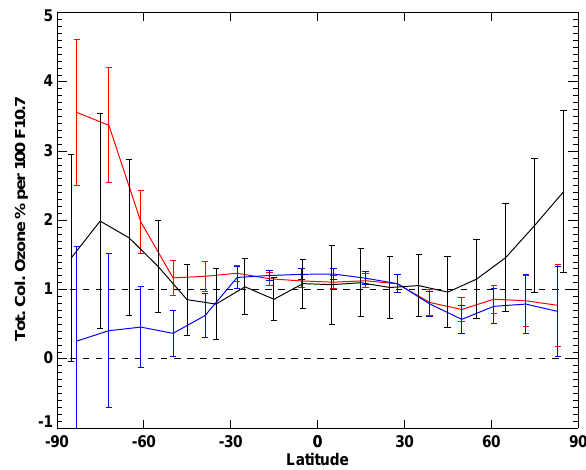
Fig. 23. Zonal mean total column O 3 regression fit against the F10.7 index for the ensemble without EPP (red) and the ensemble with EPP (blue). Regression of observed total column ozone from Fiole- tov et al. (2002) is also shown (black). The column O 3 response is in % per 100 units of F10.7. Error bars are ± 2 σ . The two dashed lines show the 0% and 1%